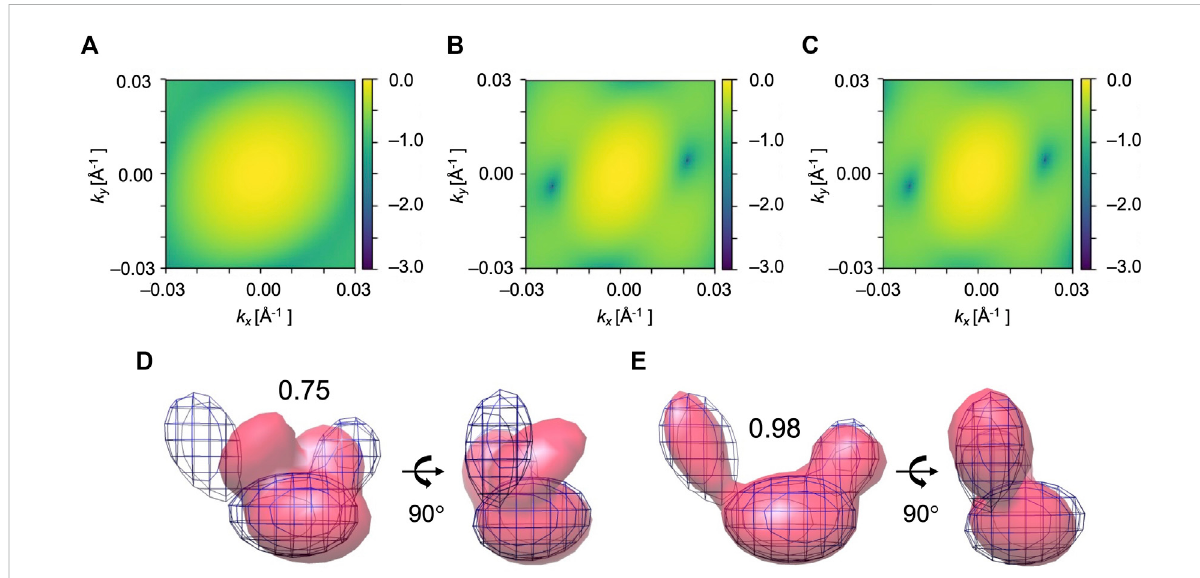
FIGURE 5 Simulated XFEL diffraction patterns of initial (A) , candidate (B) , and target (C) GMM models from the fi tting of AK. k x and k y represent the wavenumbersofdiffractionvectors(without2 π ).Initial2DCCbetween (A) and (C) was0.17,whichincreasedto0.99betweenthe (B) and (C) afterthe MC simulation process. GMM representations of AK before and after the fi tting are shown. (D) The initial model is in pink, the reference GMM representation of the target model is in blue mesh. Initial 3D CC between the initial model and target is 0.75. Incident beam orientation is directed into the plane of paper for the left-side structure and from right to left for the right-side structure. (E) The candidate model is in pink, the reference GMM representation of the target model is in blue mesh. The fi nal 3D CC between the candidate model and target is 0.98.